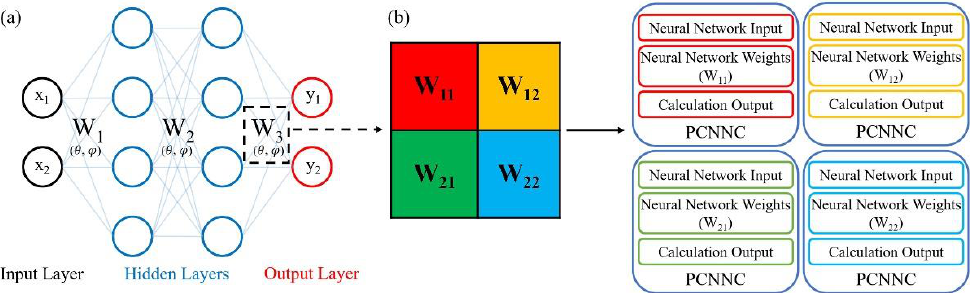
Figure 2. ( a ) The multicore architecture of the PCNN chip. ( b ) Shown are 2.5D integration and 3D integration of the PCNN chip and the electronic chip. PCNNC: photonic complex-valued neural network chip; DAC: digital-to-analog converter; ADC: analog-to-digital converter.